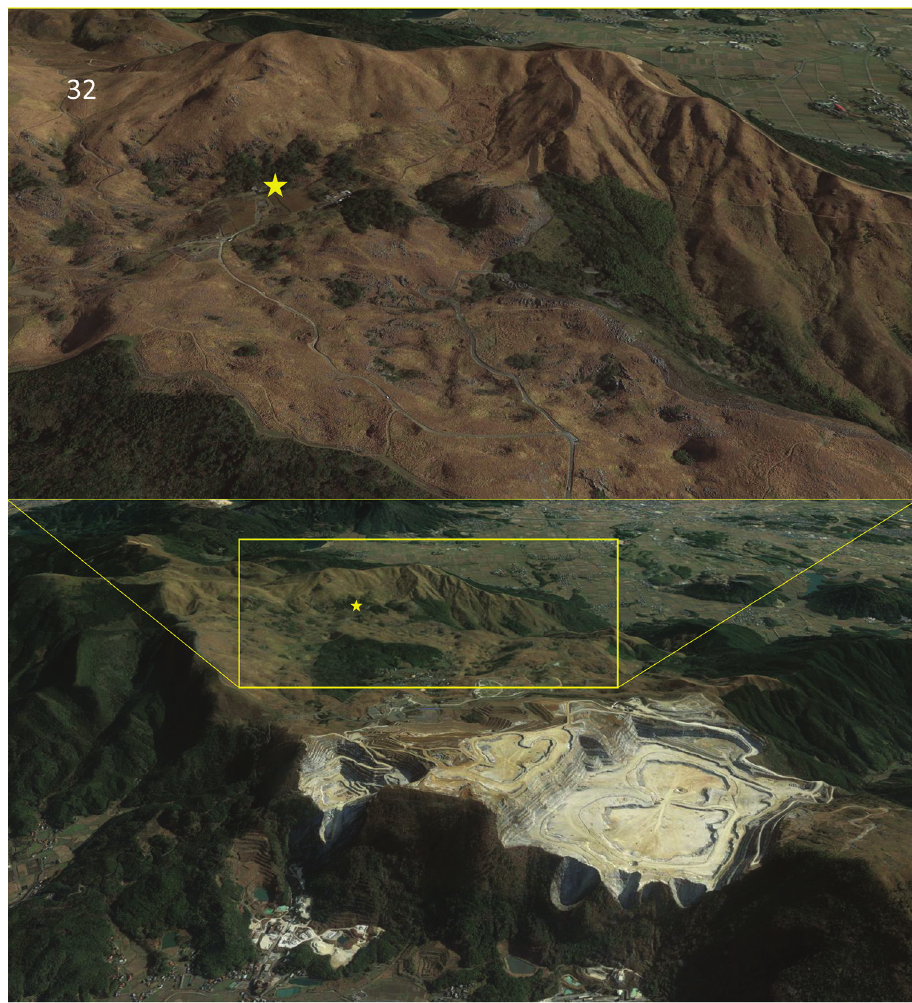
Figure 32. Karst landscape in the area where Mejiro-do cave is located (yellow star). Below, the quarry, whose limits are less than 2km from the Mejiro-do cave